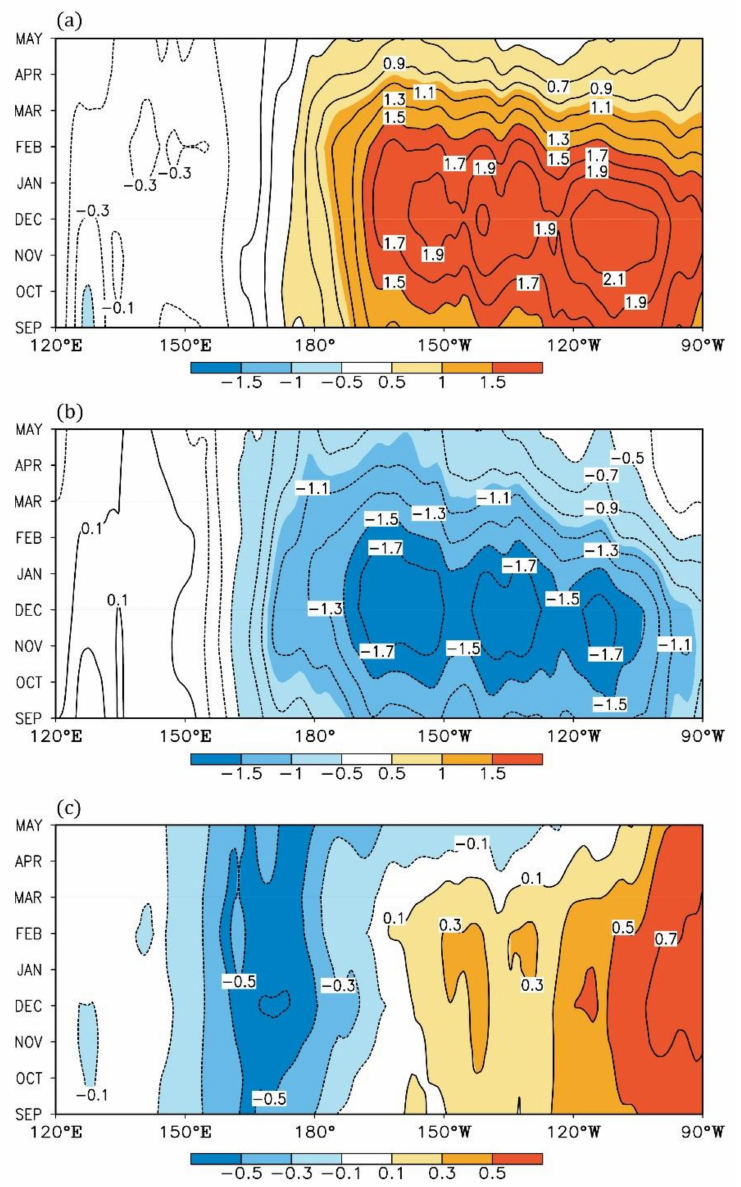
Figure 4. Composite monthly evolutions of SST anomalies (contours and colors; units: ◦ C) averaged over 2 ◦ S–2 ◦ N from developing autumn (SEP) to decaying spring (MAY) in the ( a ) El Niño cases and ( b ) La Niña cases. ( c ) The summation of ( a ) and ( b ). All data are linearly